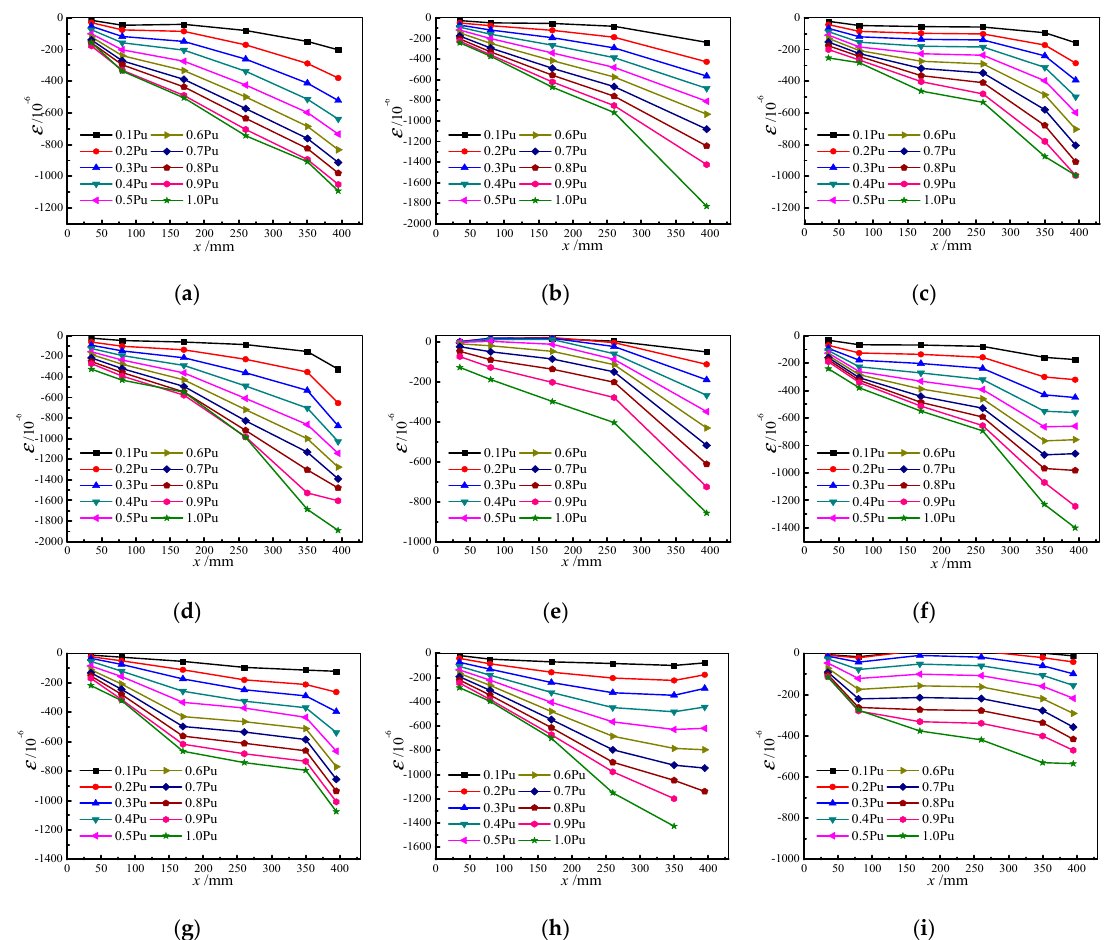
Figure 12. Strain distributed along longitudinal direction in some specimens ( a ) HSCFST-1W; ( b ) HSCFST-2W; ( c ) HSCFST-4W; ( d ) HSCFST-6W; ( e ) HSCFST-7W; ( f ) HSCFST-9W; ( g ) HSCFST-11W; ( h ) HSCFST-12W; ( i ) HSCFST-14W.